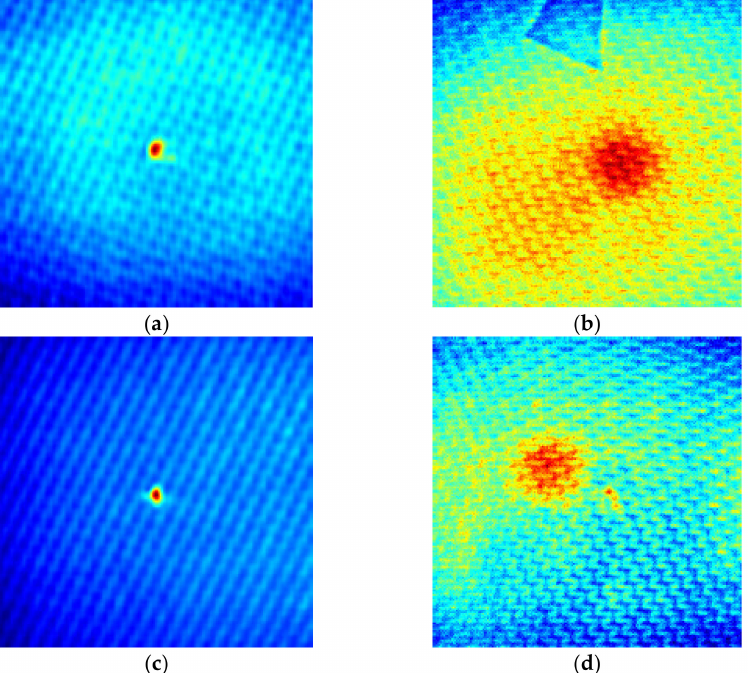
Figure 7. Thermographic images of the impact on the ( a ) front face and ( b ) back face of panel 13 and the ( c ) front face and ( d ) back face of panel